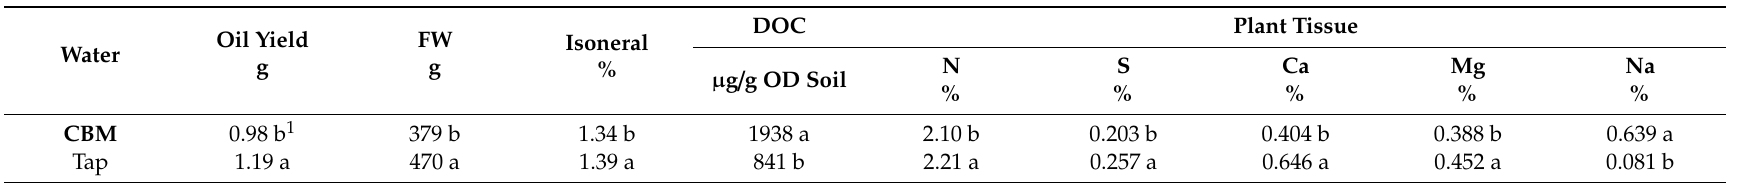
Table 4. Mean Oil yield, Fresh weight (FW), Isoneral content in lemongrass essential oil, and soil microbial C flush [DOC ( µ g / g OD soil)]; and nutrient content in plant tissue from distillation waste [Nitrogen (N), Sulfur (S), Calcium (Ca), Magnesium (Mg), and Sodium (Na)] obtained from lemongrass irrigated with Coal-Bed Methane (CBM) water and Tap water (Tap).